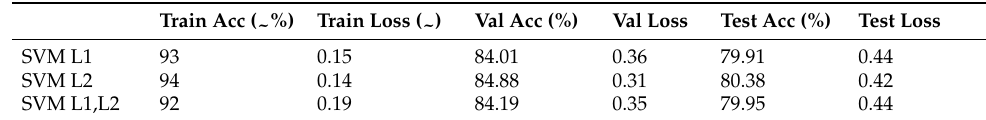
Table 11. Testing Accuracy and Loss After Model Optimisation.